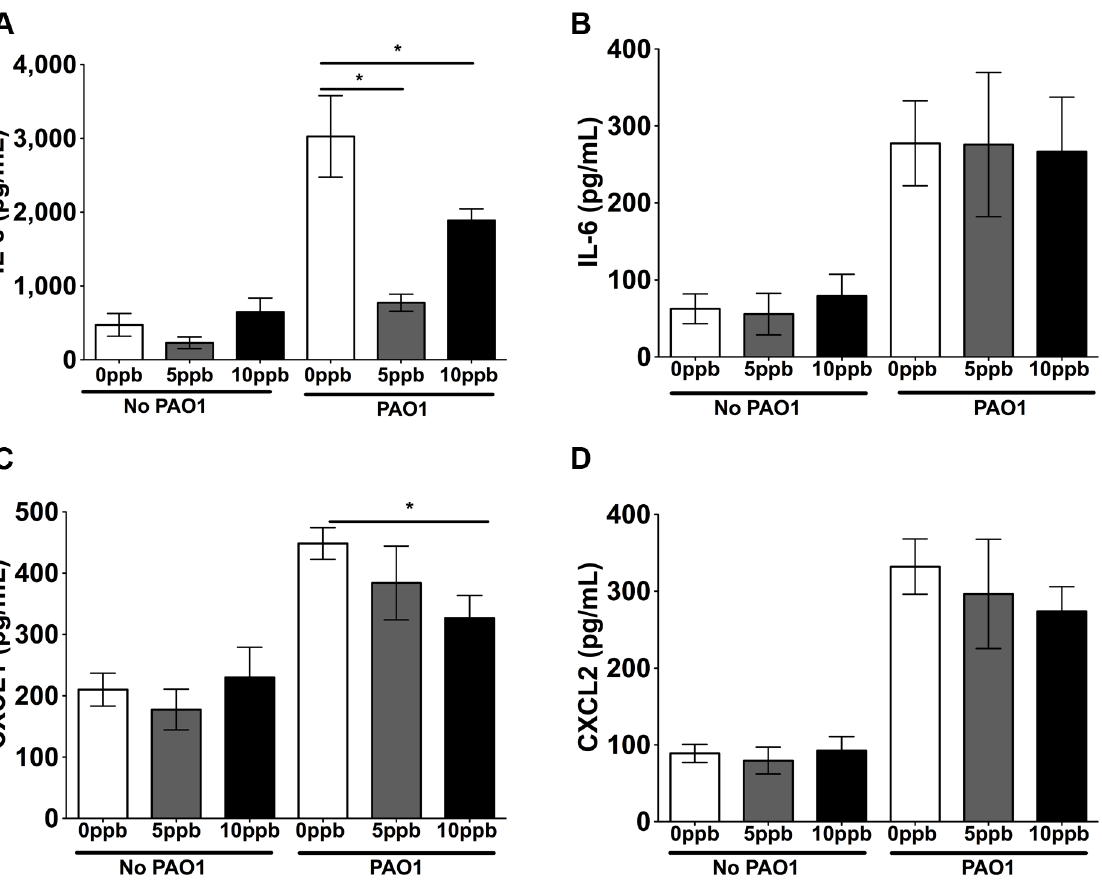
Fig 5. A combination of iAs III , MMA III and DMA V reduced P . aeruginosa stimulated cytokine secretion. Cytokine secretion by HBEC exposed to 5 ppb total arsenic (combination of 1.25 ppb iAs III + 1.25 ppb MMA III + 2.5 ppb DMA V ) ± P . aeruginosa or 10 ppb total arsenic (combination of 2.5 ppb iAs III + 2.5